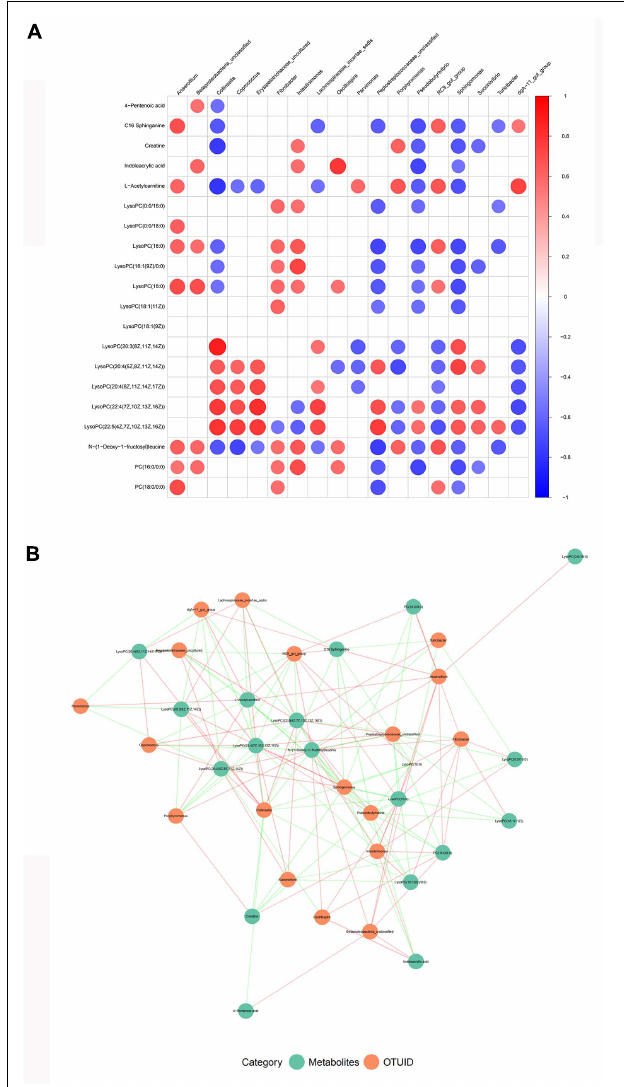
FIGURE 7 | Correlation analysis between gut microbiota and serum metabolism. (A) A correlation matrix was drawn for the TOP20 results of correlation analysis of different species and different metabolites. (B) Association network diagram of TOP20 differential species and differential